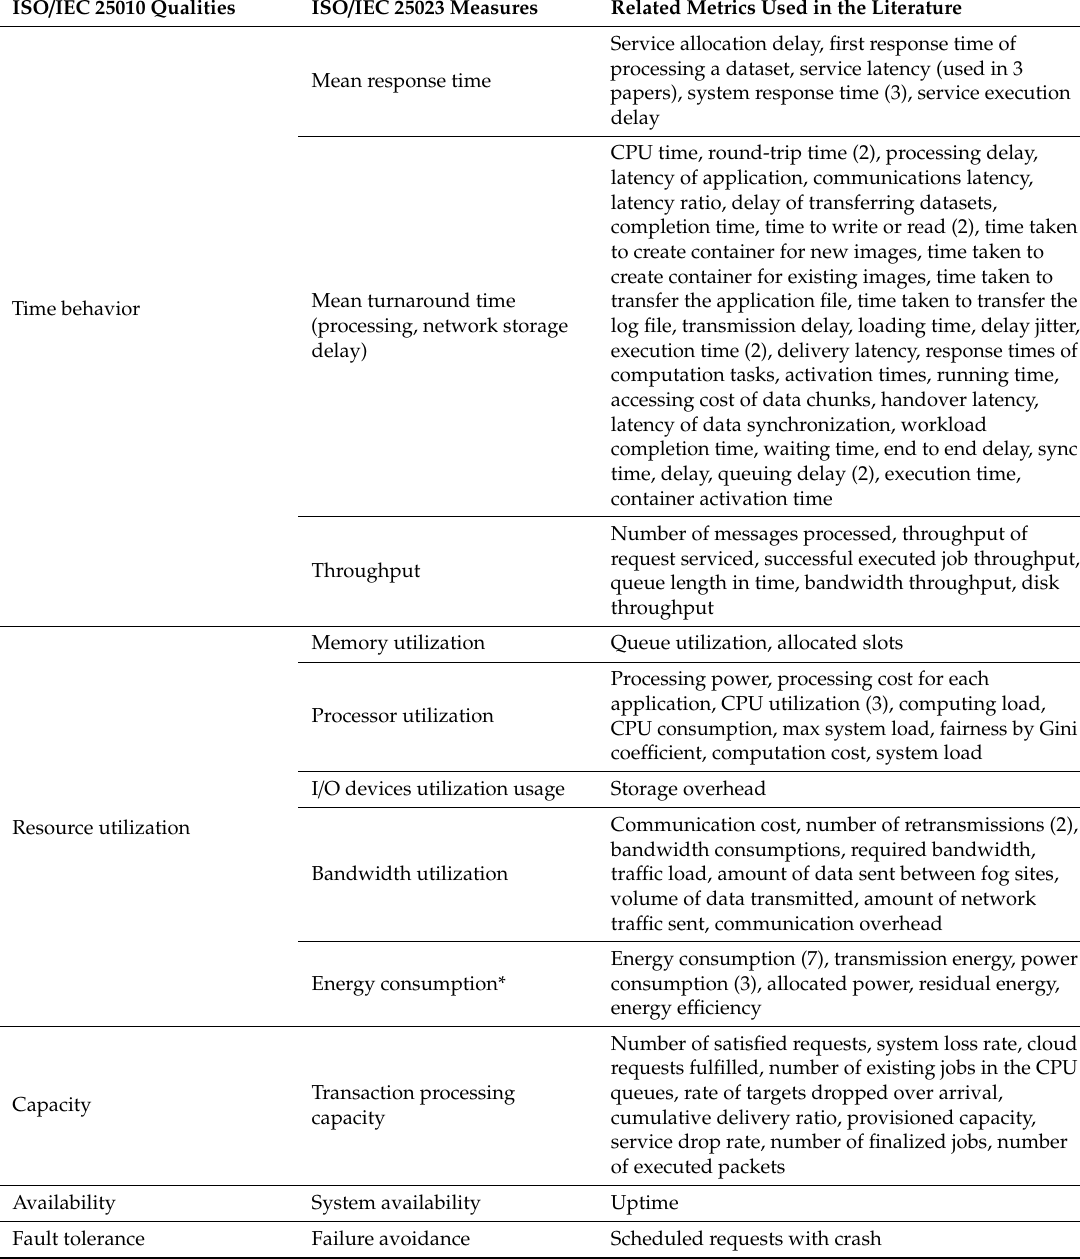
Table A1. Metrics used in the literature, categorized according to the ISO / IEC standards (the numbers between brackets show the number of papers that used the